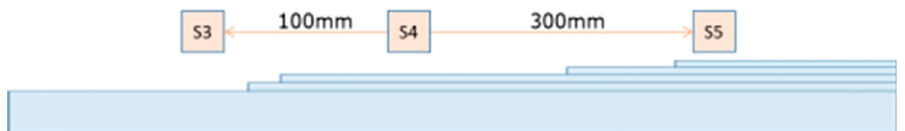
Figure 7. Schematic of plydrop specimen with the linear AE sensor array (dynamic test).